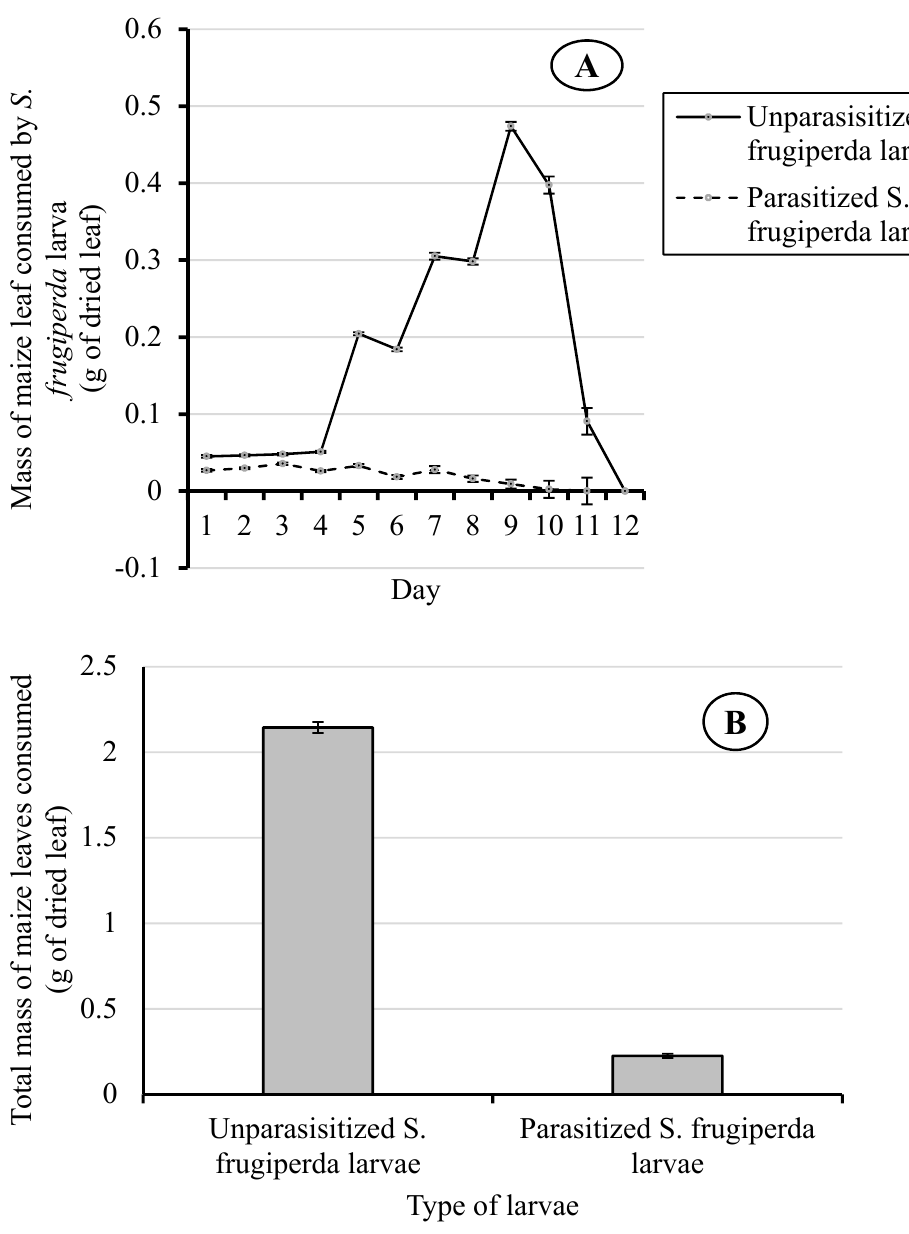
Figure 2. Daily mass of maize leaf consumed ( A ) and total consumption of maize leaves ( B ) by the parasitized and unparasitized S. frugiperda larvae.